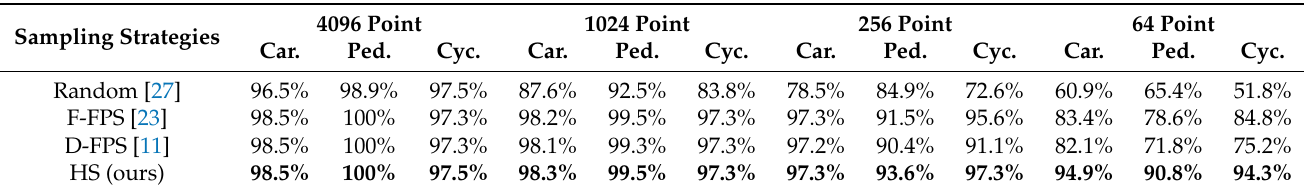
Table 5. Comparison of commonly used centralized sampling methods and HS. Sampling